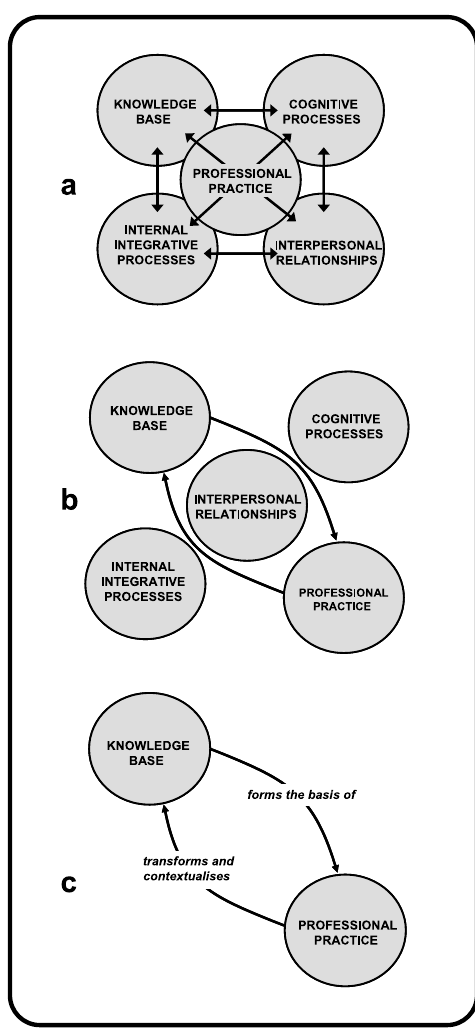
Figure 2. Developing the work of Yielder (2004, 2009)